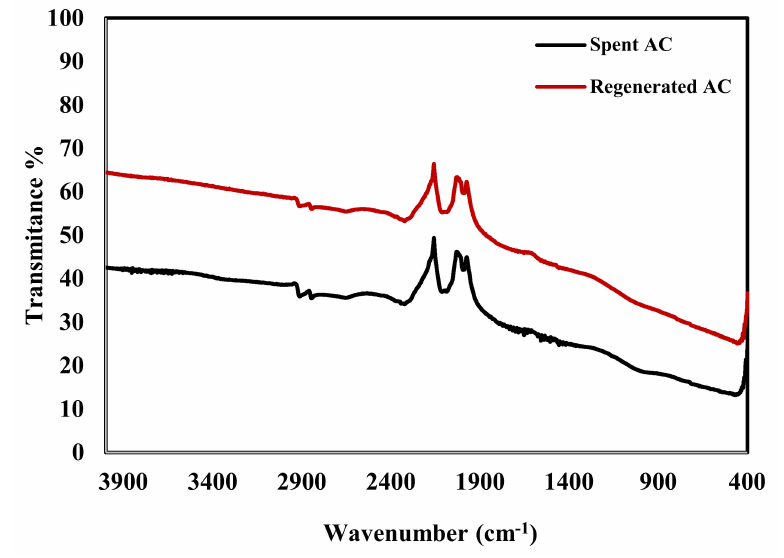
Figure 1. FTIR spectrum of the spent and regenerated activated